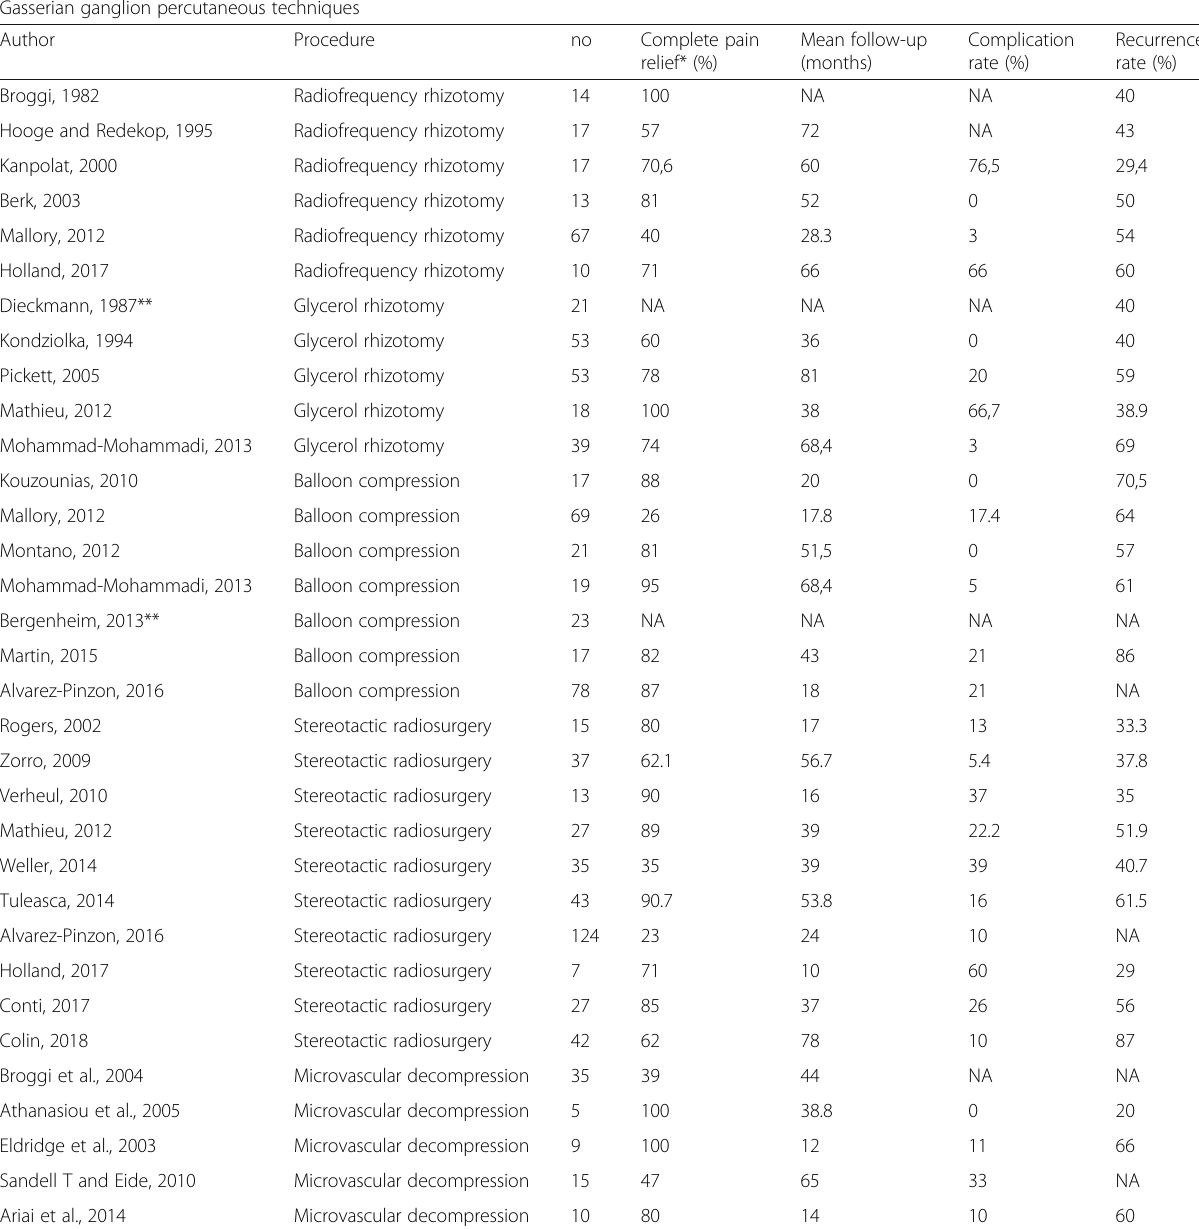
Table 1 Summary of studies dealing with gangliolysis techniques and gamma knife radiosurgery in patients with multiple sclerosis- related trigeminal neuralgia Gasserian ganglion percutaneous